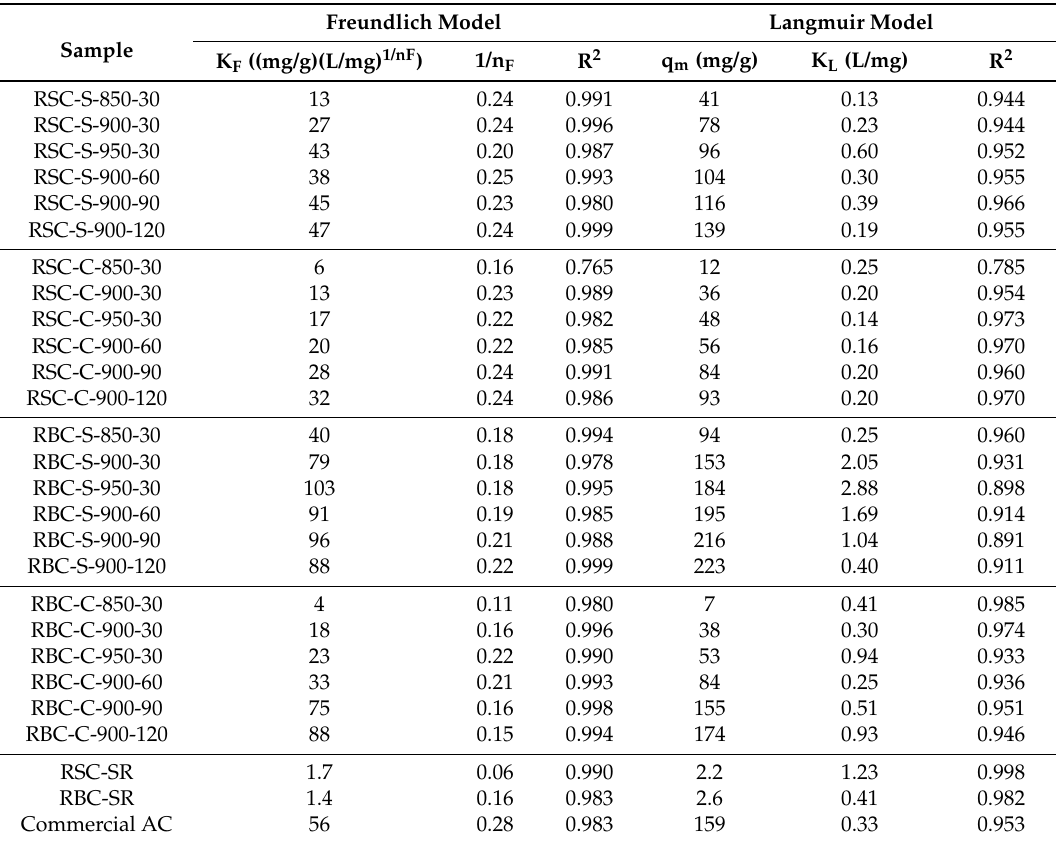
Table 4. Phenol adsorption isotherm models: model parameters and correlation coefficients of solid residues and ACs produced from RSC (after HCl washing) and RBC.